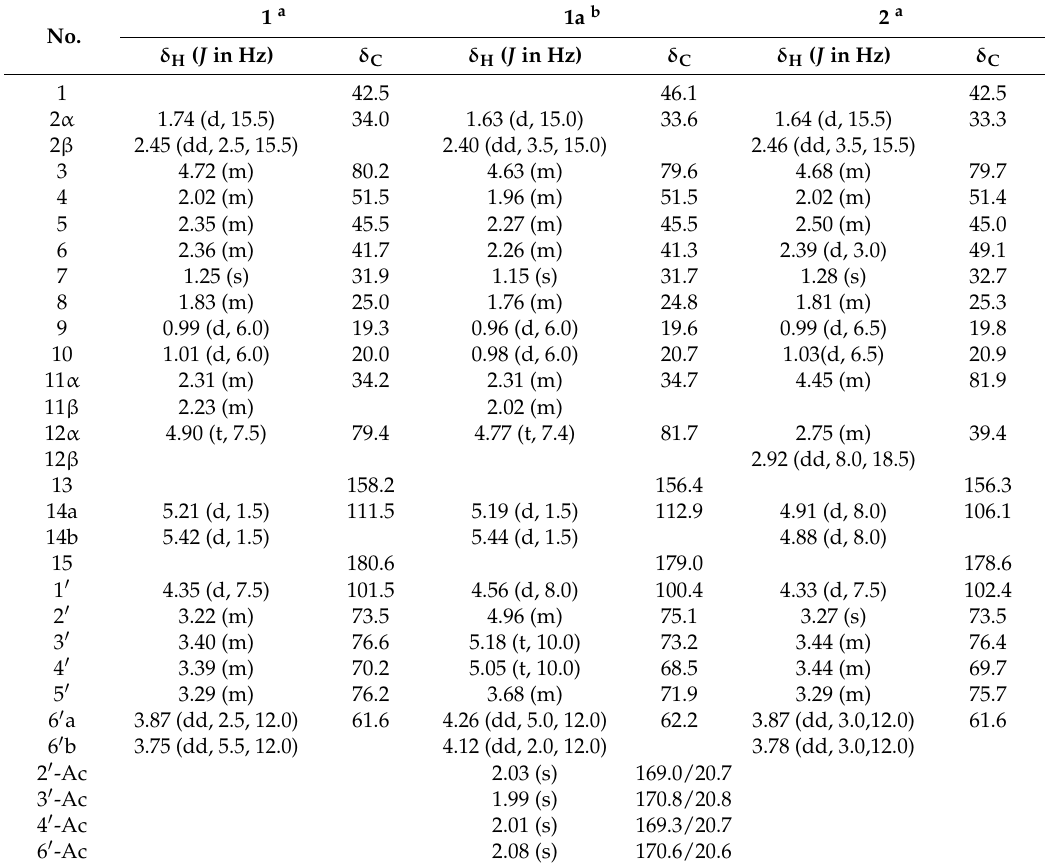
Table 1. 1 H-NMR (500 MHz) and 13 C-NMR (125 MHz) data for 1 , 1a , 1b , and 2 ( δ ppm).